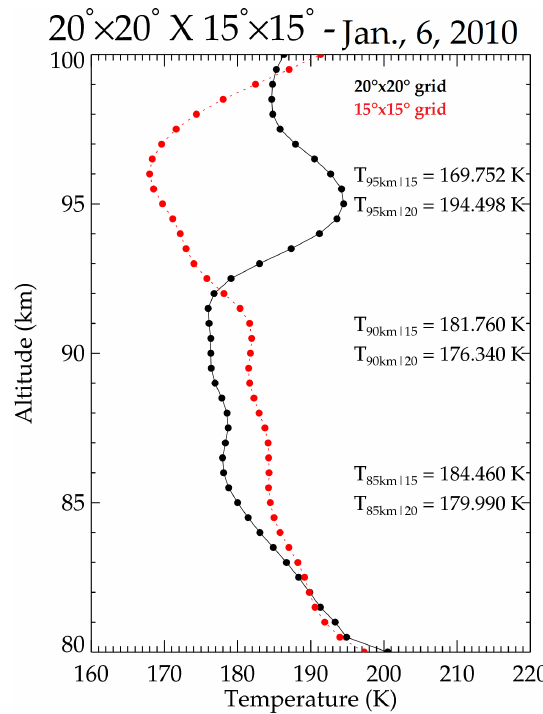
Figure 3. Temperature profiles of the MLT region as retrieved from SABER/TIMED observations over Santa Maria, southern Brazil, on 6 January 2010. The 20 ◦ × 20 ◦ lat/long grid profile is shown in black, while the 15 ◦ × 15 ◦ profile is shown in